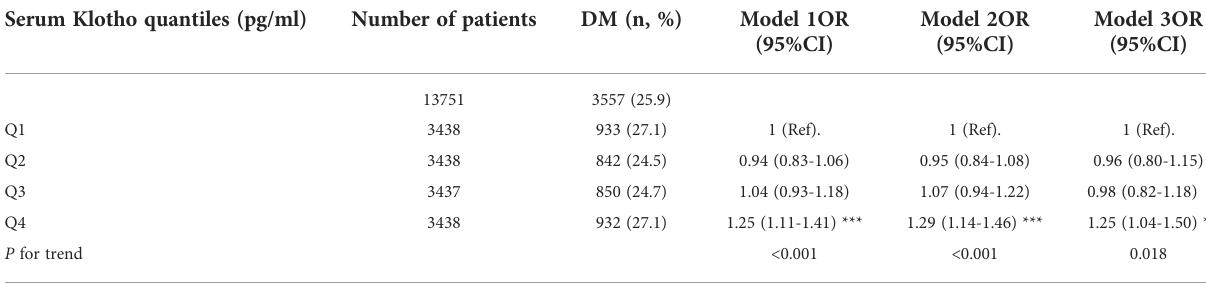
TABLE 2 Association between serum Klotho levels and diabetes mellitus in the database from NHANES 2007-2016. Serum Klotho quantiles